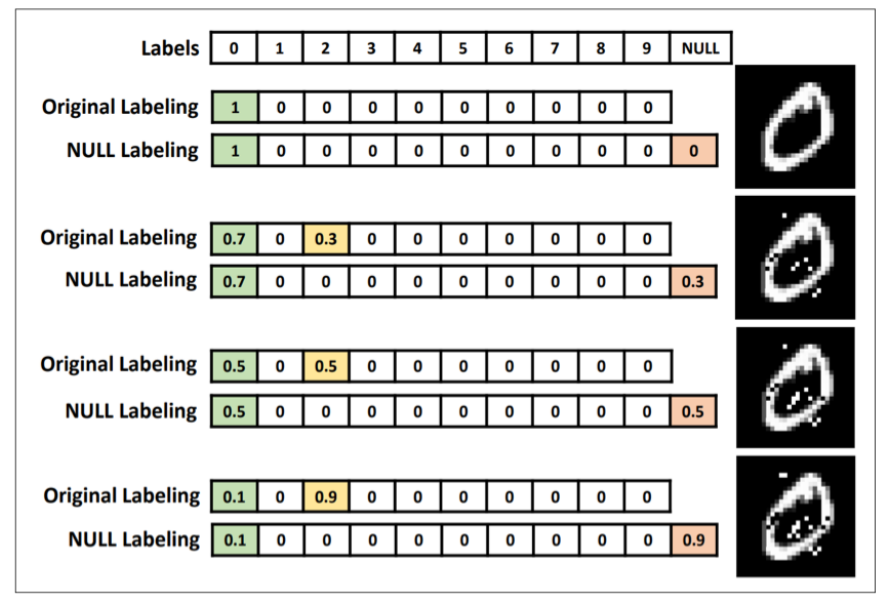
Figure 15. Illustration of the original and null labeling methods on an image from the MNIST dataset, and three adversarial examples with different perturbations. The classifier assigns a probability vector to each image. With more perturbation, the NULL labeling method assigns a higher probability to the NULL label, while the original labeling increases the probabilities of other labels (Image Credit: Hosseini et al.